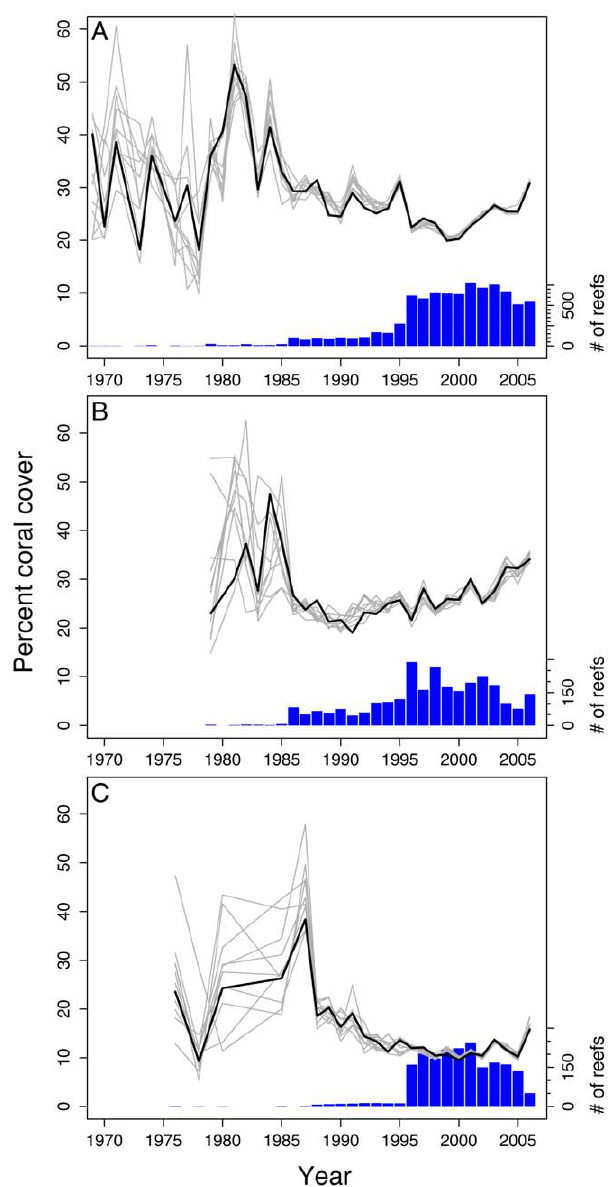
Figure 2. Comparisons of the average coral cover per year as predicted by the models. Simulated data sets (light grey lines) with the observed mean coral cover per year (thick black line) for ( A ) MPA versus control model, ( B ) MPA-only Caribbean years of protection model, and ( C ) MPA-only Indo-Pacific years of protection model. The histograms at the bottom of the figures display the relative sample sizes at each year for the actual data. In all models, the earlier years had less data and therefore exhibit more variation in behavior. In the ‘year of protection’ models there was not sufficient data to accurately estimate percent coral cover so the simulation results begin in later years. Note that the right y-axes are different in each of the plots due to the varying number of observations in each model.